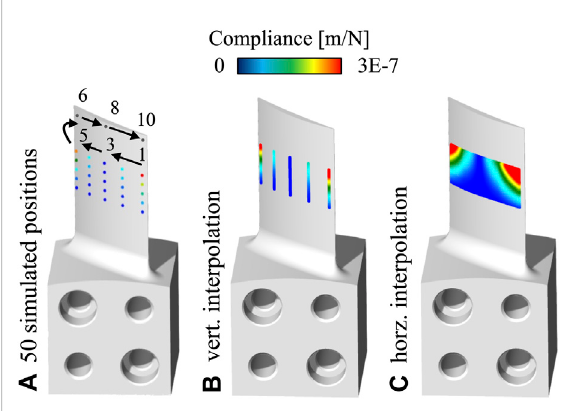
FIGURE 6 Setup of FEM simulation in ANSYS, e.g., meshed IPW of CL62 assigned to block 2. (A) Boundary conditions, (B) Meshed in- process workpiece, (C) Result of FE modal analysis.